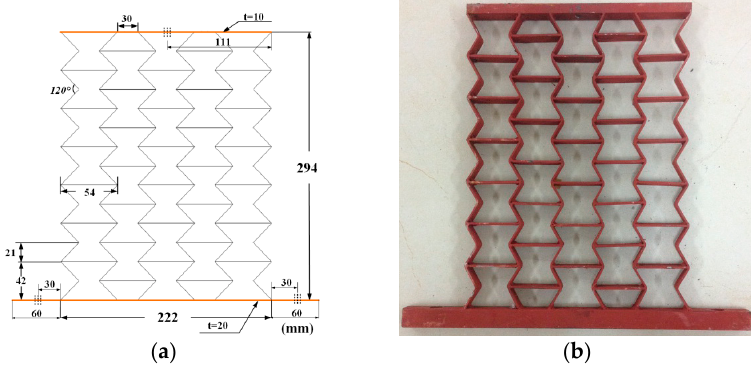
Figure 11. Testing samples with the cell angle 30 : ( a ) geometric dimensions; ( b ) photo.